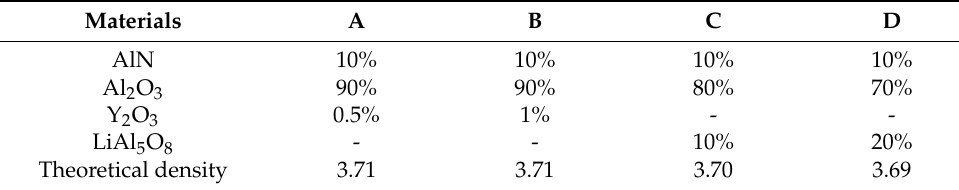
Table 1. Composition design for the sintering